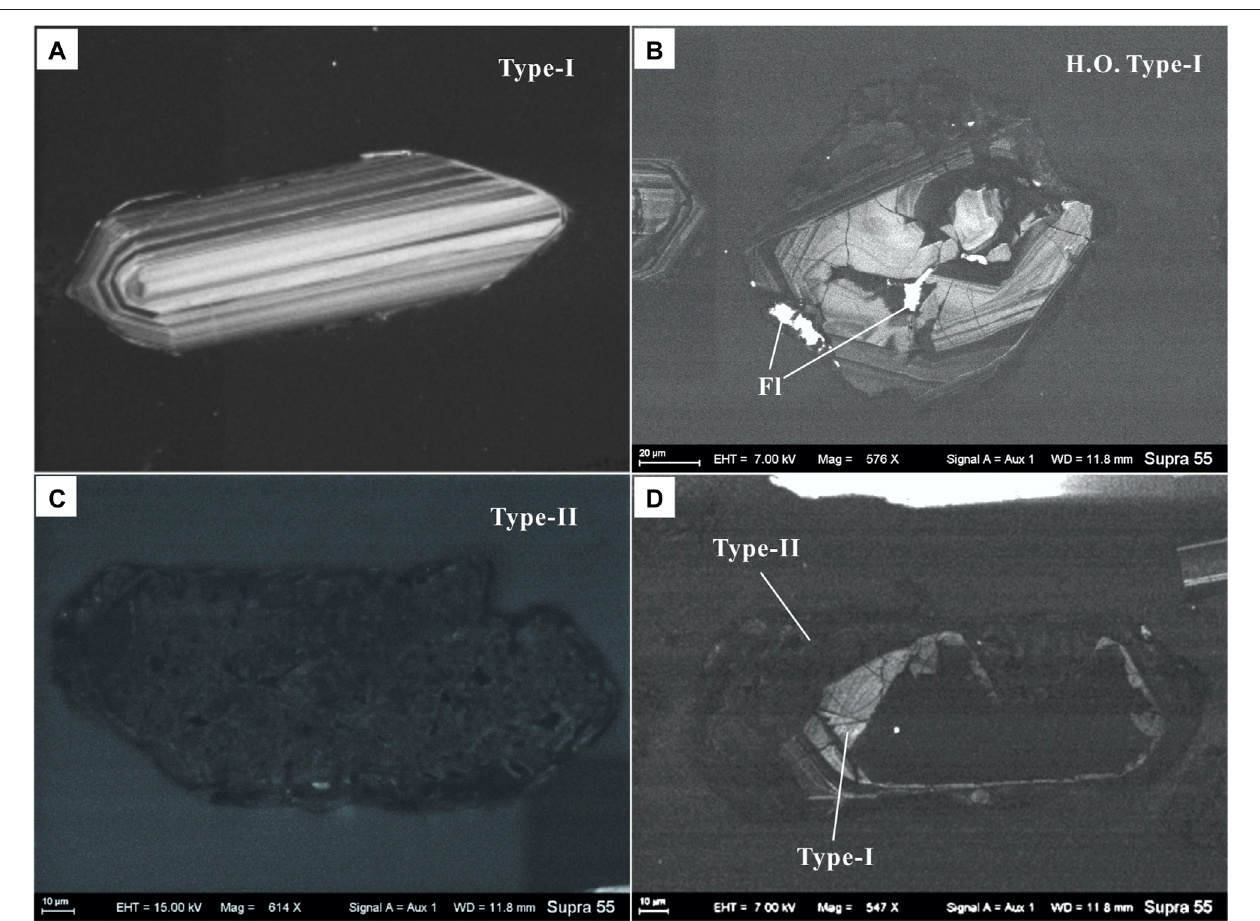
FIGURE 5 | Cathodoluminescence (CL) images of zircons from the BST pluton. (A) Type – I zircon with oscillatory zoning. (B) Type – I zircon with the hydrothermal overprinting. Fluorite inclusion occur in the microcracks of the H.O. type – I zircon. (C) Subhedral, dark and inhomogeneous type – II zircon grain. (D) Zircon grains with core – rim structure. H.O. type – I zircon in core and type – II zircon in edge.